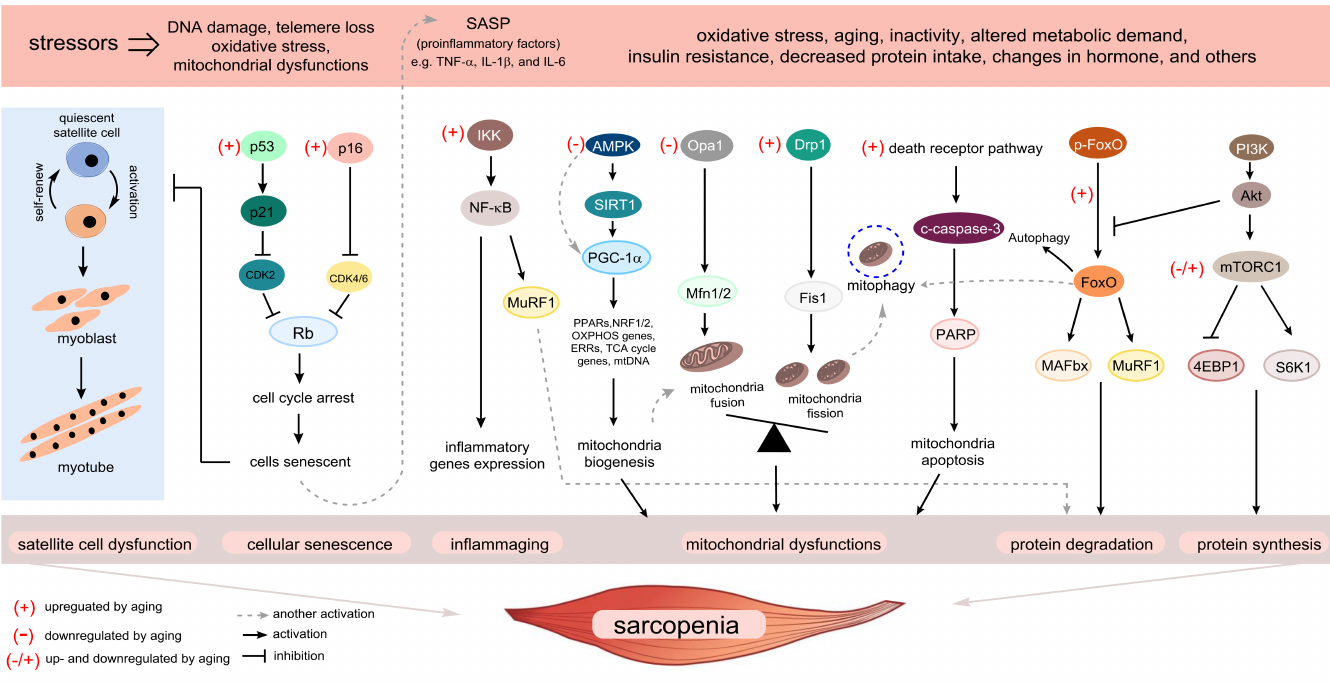
Figure 1. Overview of the fundamental aging mechanisms that contribute to sarcopenia. During the aging process, a variety of stressors engage various cellular signaling cascades, ultimately facilitating the progression of sarcopenia. Several senescence-inducing stimuli cause senescence of satellite cells leading to the loss of capacity to repair upon muscle injury. Many of these stimuli cause the upregulation of p53–p21 Cip1 and p16 Ink4a pathways, which induce a temporal cell-cycle arrest by inhibiting cyclin-dependent kinase (CDK) 2 and CDK4 / 6, respectively. When cells enter a senescent state, the senescence-associated secretory phenotype (SASP) is expressed in those cells as a paracrine signaling pathway. “Inflammaging” and SASP production in senescent skeletal muscle cells converge on activation of nuclear factor kappa B (NF- κ B) signaling, which induces upregulation of muscle ring finger 1 (MuRF1). Activation of the aging process causes mitochondrial dysfunction by deactivation of the sirtuin 1–peroxisome proliferator-activated receptor γ coactivator 1- α (PGC-1 α ) axis, which is primarily responsible for the maintenance of mitochondrial quality control. The accumulation of damaged mitochondrial DNA due to an imbalance in mitochondrial dynamics will be eliminated via mitophagy. However, under aging conditions, ine ffi cient mitophagy eventually induces apoptosis. Aging interrupts the coordinated balance between protein synthesis and degradation, which activates and interconnects with multiple signaling pathways. Muscle atrophy F-box (MAFbx) and MuRF1, the major muscle-specific E3 ubiquitin ligases, are increased by activation of the transcription factor forkhead box O (FoxO) by aging stimuli, while the roles of Akt / mammalian target of the rapamycin (mTOR) signaling pathway in sarcopenia are controversial. Several possible mechanisms shown here could contribute to sarcopenia and be targets of